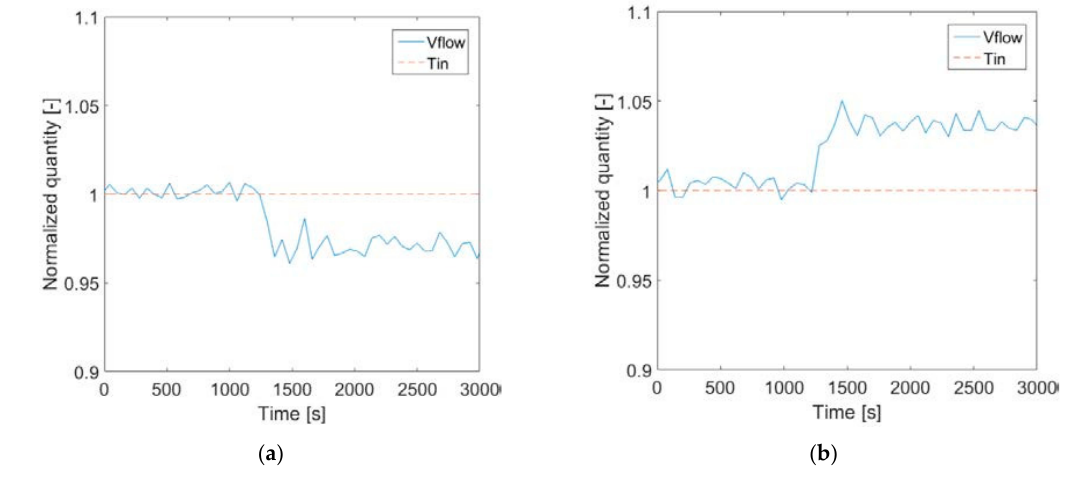
Figure 10. Thermal brine input volume flow rate and temperature: measured time behavior for ( a ) Case 1; and ( b ) Case 2. (“Vflow” = volume flow rate, “Tin” = inlet temperature).